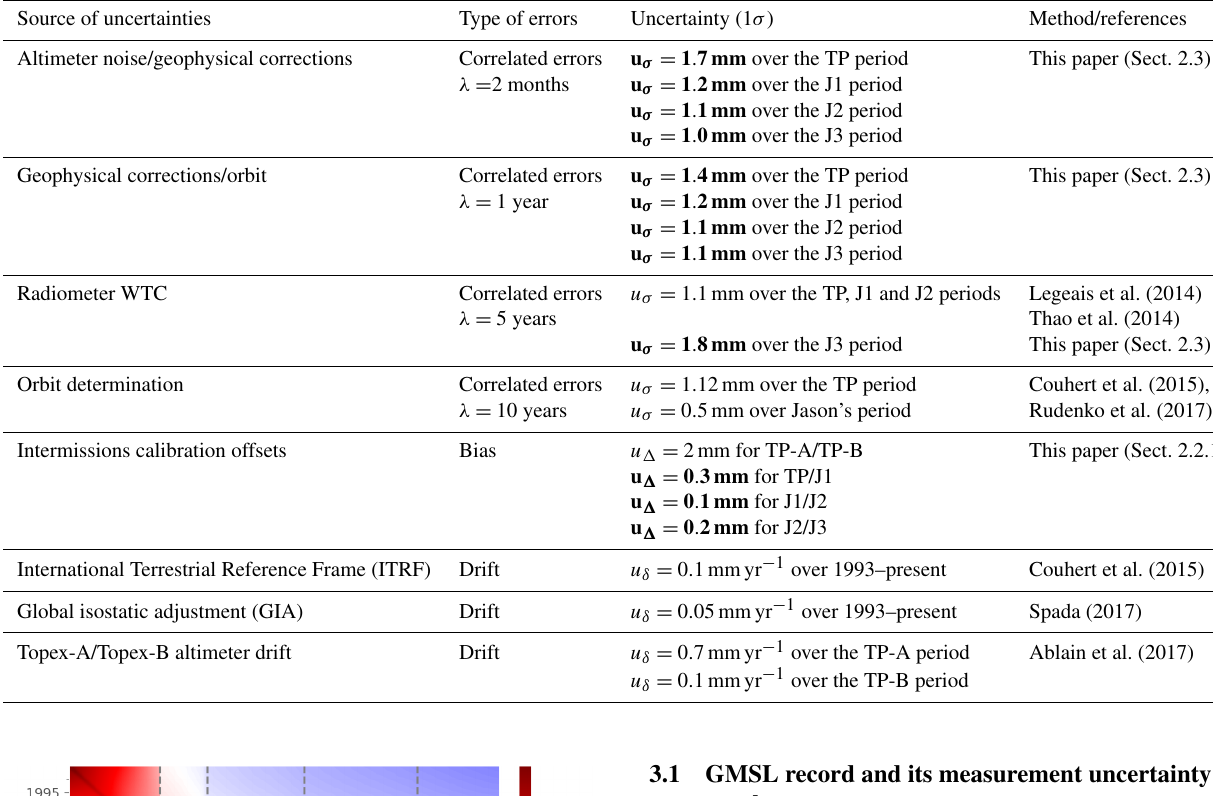
Table 4. L2P21 GMSL uncertainty budget given at 1 σ . The sources of uncertainties are based on the work of Ablain et al. (2019) and have not been changed. The values in bold are the ones updated as compared to the uncertainty budget of the previous CNES/AVISO+ GMSL record.